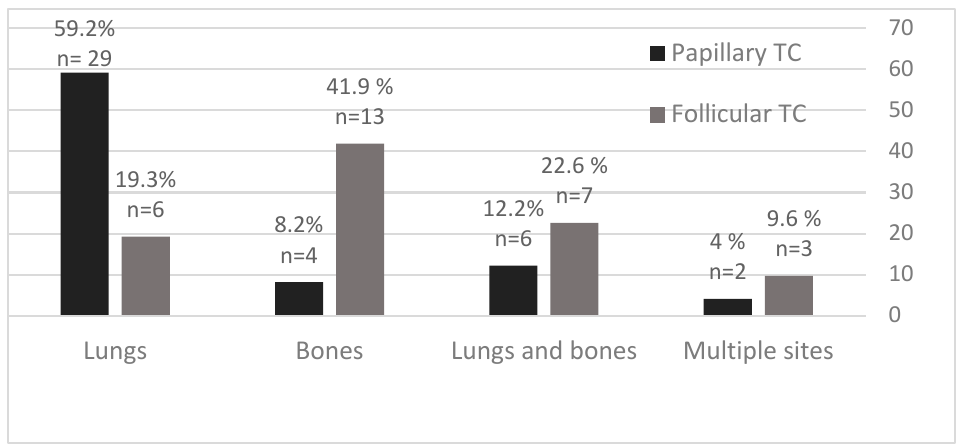
Figure 3. Distant metastases of PTC and FTC in percentage (%) and number according to the site of metastasis.